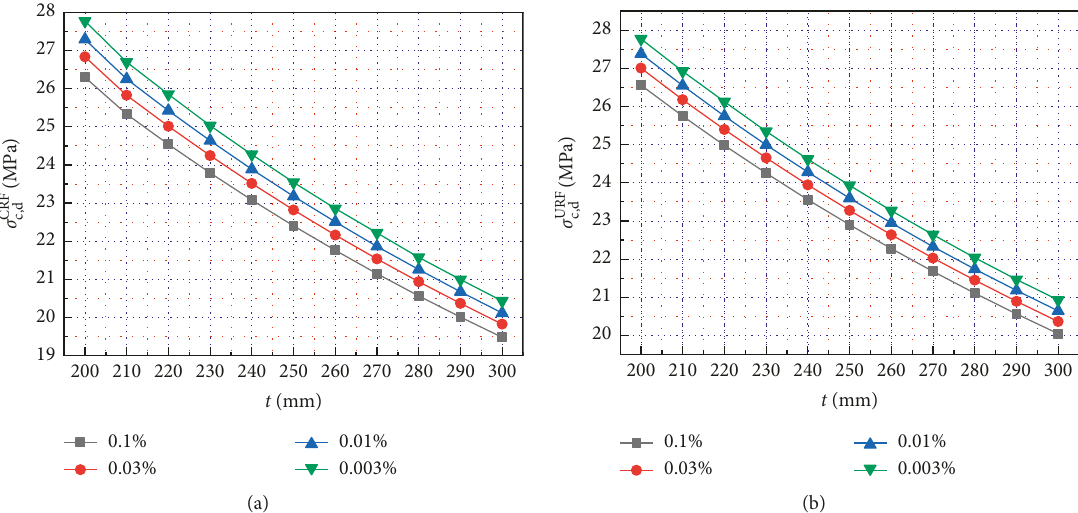
Figure 15: The relationship between the designed compressive strength and liner thickness under different random fields for different target probabilities of failure: (a) CRF and (b) URF.